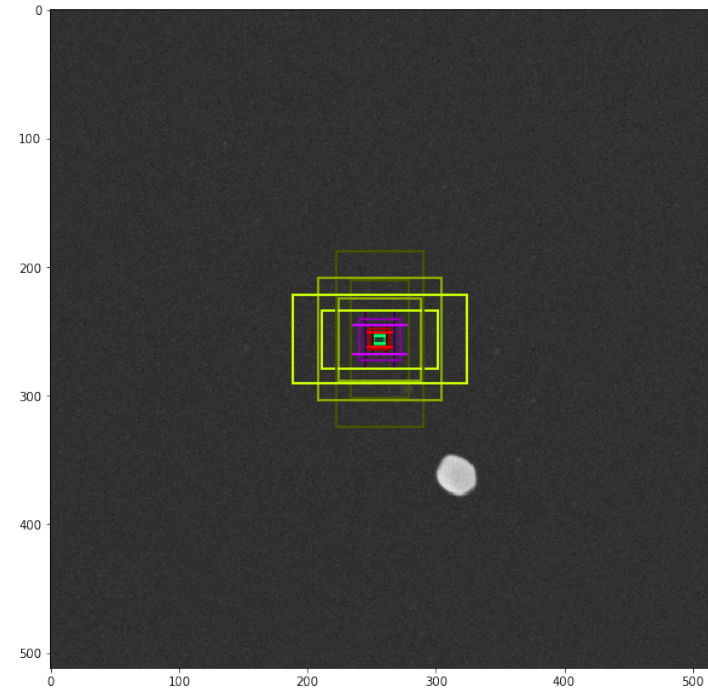
Figure 7. Different anchors sizes and shape at one